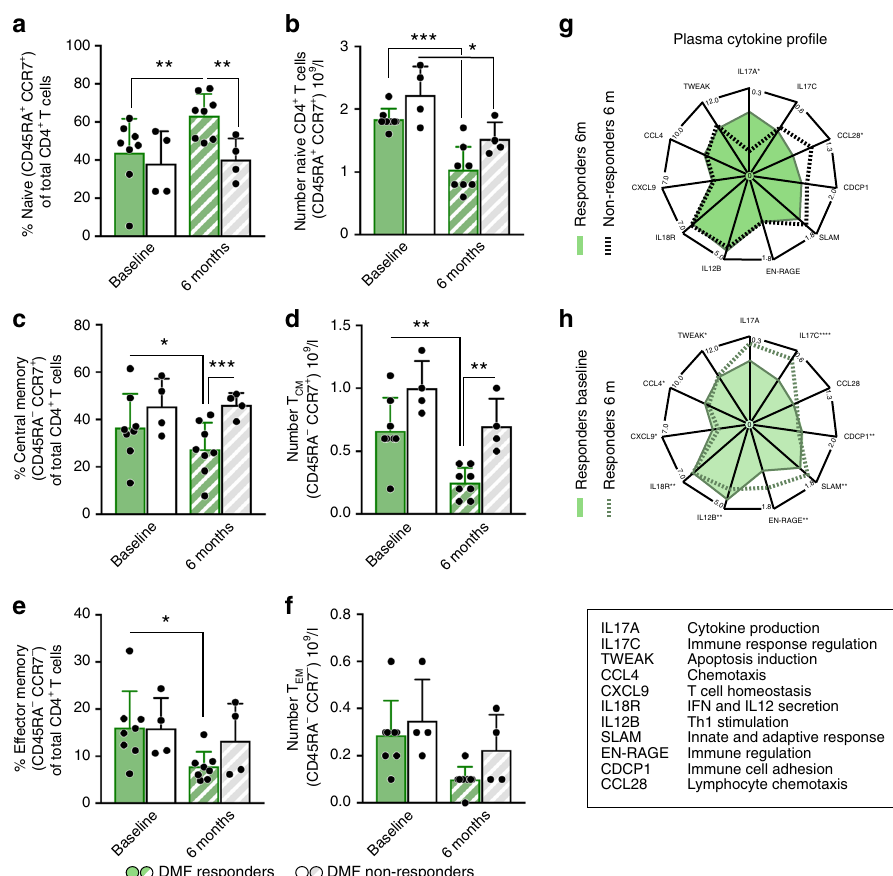
Fig. 6 DMF responders show altered levels of CD4 + T cells subsets compared to non-responders. a , b Percentage and absolute number of naïve cells of CD4 + T cells was analyzed in DMF responders ( n = 8) and non-responders ( n = 4) at baseline and after six months. c – f Central memory T cells (T CM ) was de fi ned as CD45RA − CCR7 + and effector memory T cells (T EM ) as CD45RA − CCR7 + . Graphs show means and S.D. and all analysis between paired patients are performed with paired t test. g , h Normalized protein expression (NPX) in plasma of IL17A, IL17C, CCL28, CDCP1, SLAM, EN-RAGE, IL12B, IL18R CXCL9 CCL4 and TWEAK were analyzed in responders ( n = 29) and non-responders ( n = 9) at baseline and 6 months after DMF intervention. * P < 0.05, ** P < 0.01, *** P < 0.001. Asterisk in ( d ) indicate P value adjusted for multiple testing. **adj P < 0.01, ***adj P <